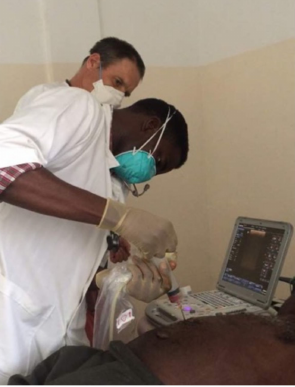
Figure 5. Ultrasound-guided puncture of a liver